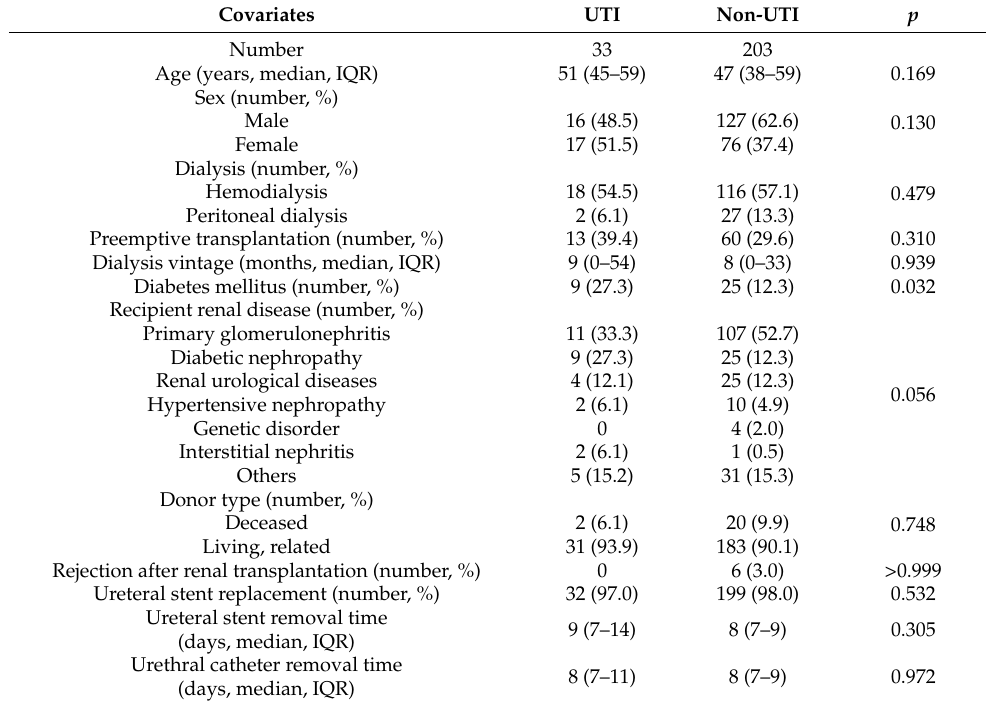
Table 1. Clinical characteristics of